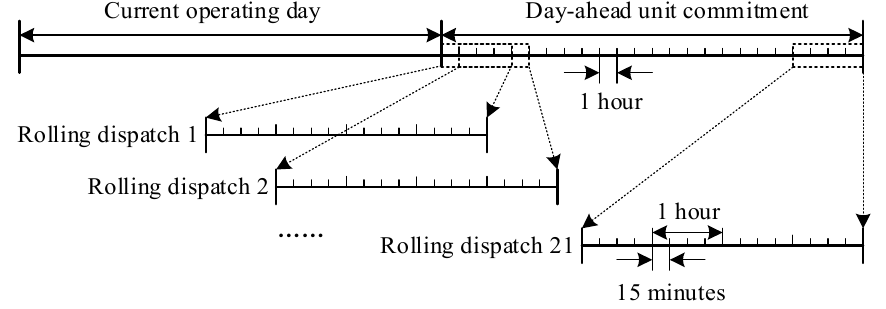
Figure 1. Diagram representation of the overview framework.